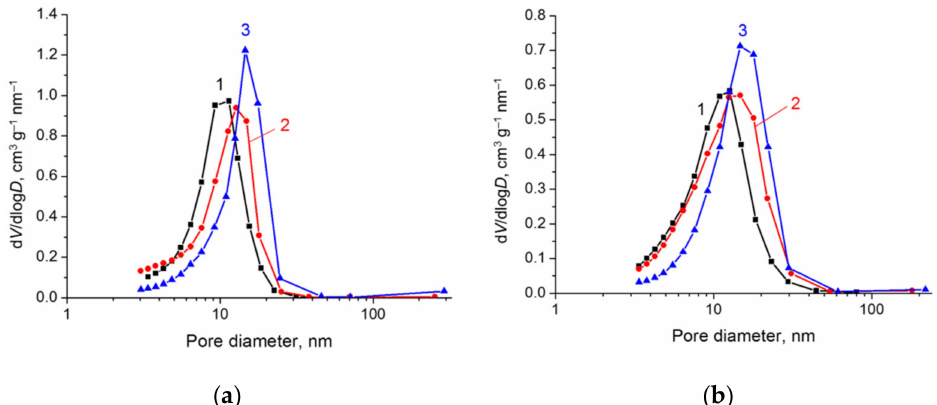
Figure 7. The pore size distribution curves plotted from the N 2 adsorption branch for the samples with different Ni/Al atomic ratio: ( a ) Ni/Al = 2; ( b ) Ni/Al = 4. Line 1 corresponds to NiAlO x obtained by calcination of NiAl LDH at 600 ◦ C, line 2 corresponds to Ni@NiAlO x obtained by calcination of NiAl LDH at 600 ◦ C and subsequent reduction with H 2 at 500 ◦ C, and line 3 corresponds to Ni@NiAlO x obtained by calcination of NiAl LDH at 600 ◦ C and subsequent reduction with H 2 at 600 ◦ C.